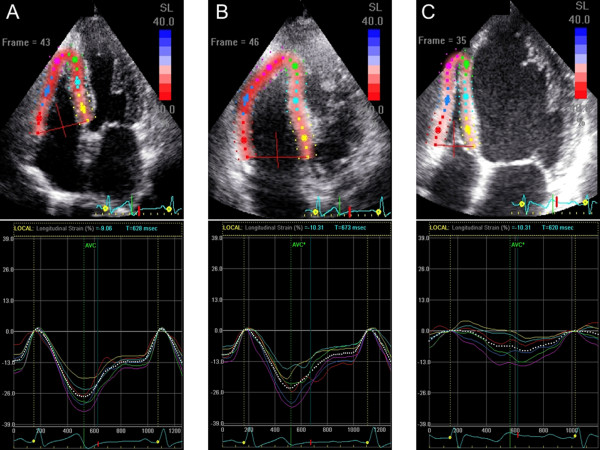
Examples of RV strain imaging in the apical four-chamber view (top) and corresponding time-strain curves (bottom) from the same subjects shown in the Figure4. (A) the normal subject, (B) the patient with OMI in the territory of left anterior descending artery and low plasma BNP level, and (C) the patient with OMI in the all 3 coronary artery territories and high plasma BNP level.